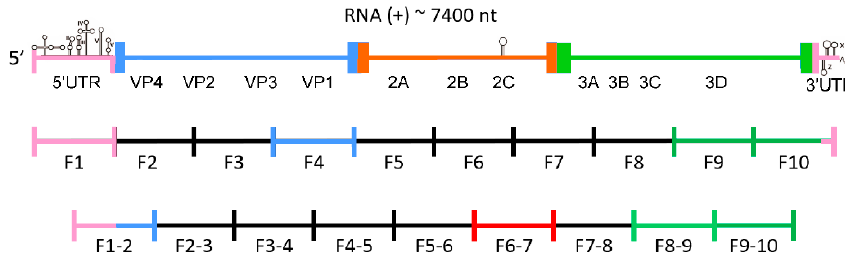
Figure 1. Scheme of coxsackievirus B3 genome organization with division into fragments, ca. 750 nt each. Fragments examined in this study are highlighted with colors corresponding to respective regions of the viral genome; UTR—untranslated region; VP1, VP2, VP3, VP4—capsid proteins ; 2A, 2B, 2C, 3A, 3B, 3C, 3D—non-structural proteins;.